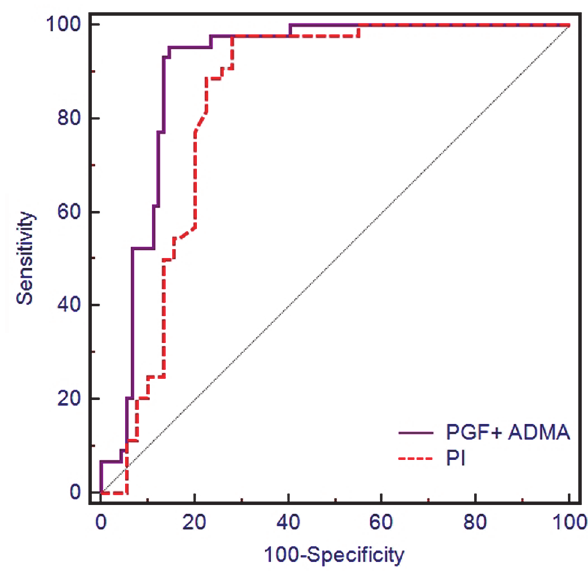
Fig 4. ROC curves for second trimester uterine artery PI and first trimester PGF and ADMA levels for prediction of preeclampsia.